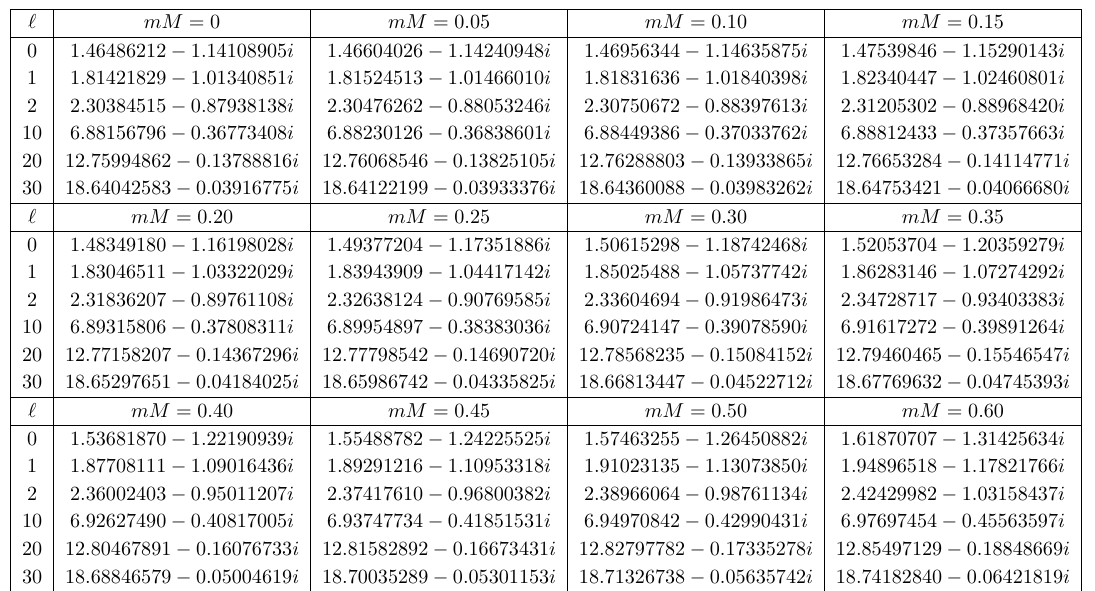
Table 8 . Fundamental quasinormal frequencies !M ( n = 0) of massive scalar (cid:12)elds with ‘ = 0 ;